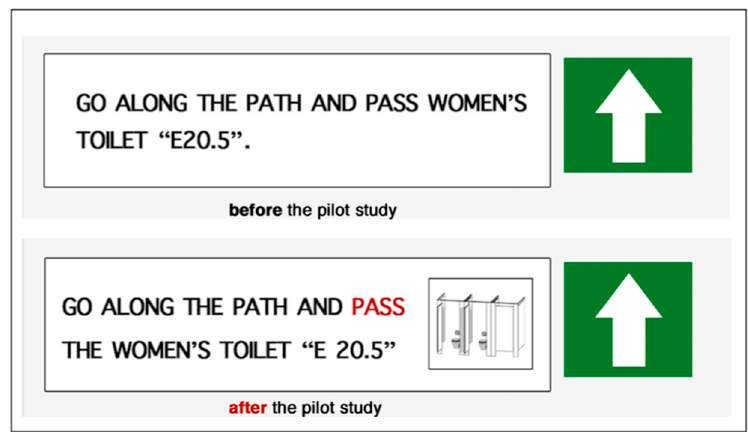
Figure 17. Integration of axonometric-based landmarks within the routing instructions (based on pilot study feedback).